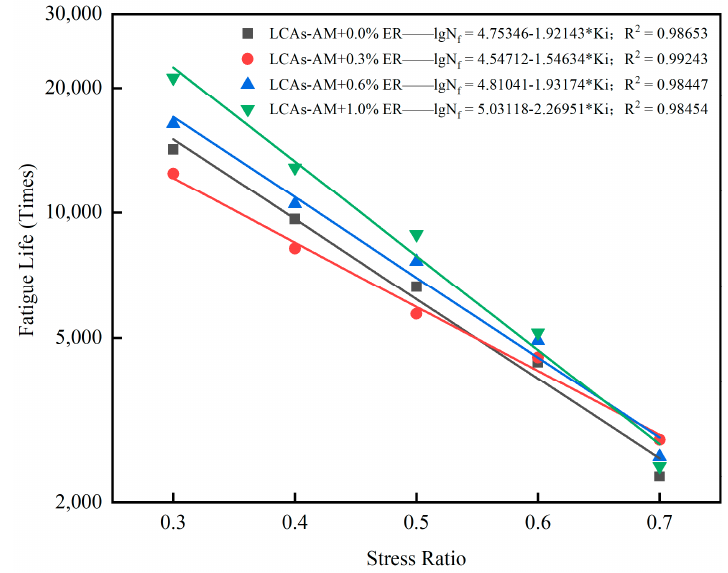
Figure 13. Fatigue life of LCA-AMs with ER.